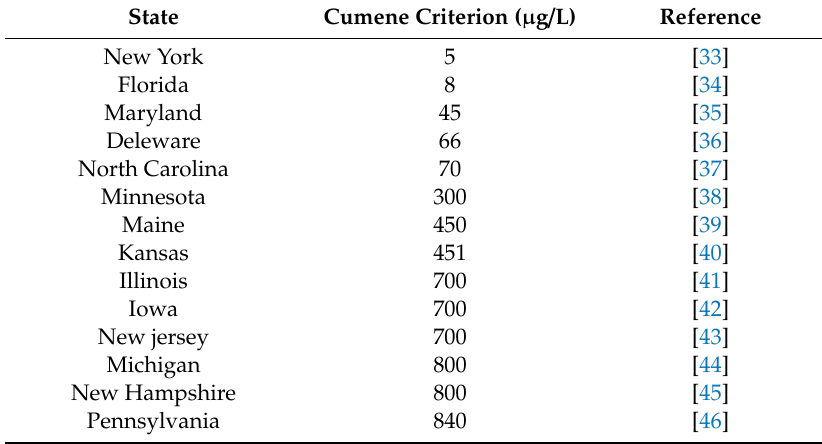
Table 3. Regulatory groundwater standard for cumene by